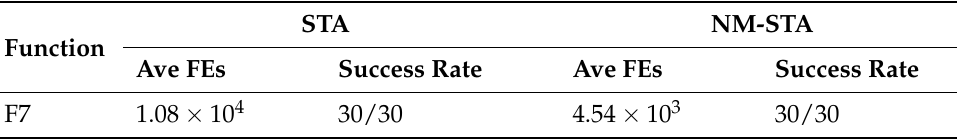
Table 1. Statistical results for STA and NM-STA with D = 2.